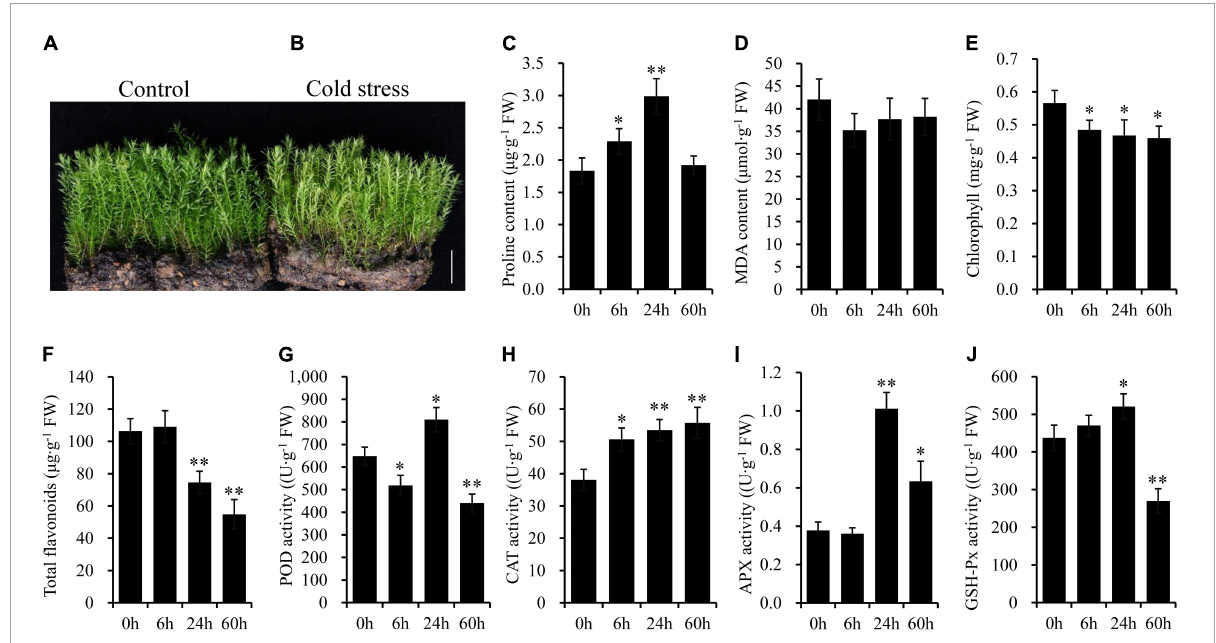
FIGURE1 The moss Pohlia nutans has a potential capability of tolerance to cold stress. (A) Photo of moss gametophytes grown under normal condition. (B) Photo of moss gametophytes placed under 0 ◦ C for 60 h to carry out cold stress. (C–J) The biochemical features of mosses under cold stress. All experiments were repeated three times. Significant difference ( ∗ P < 0.05, ∗∗ P < 0.01). Scale bar = 1.0